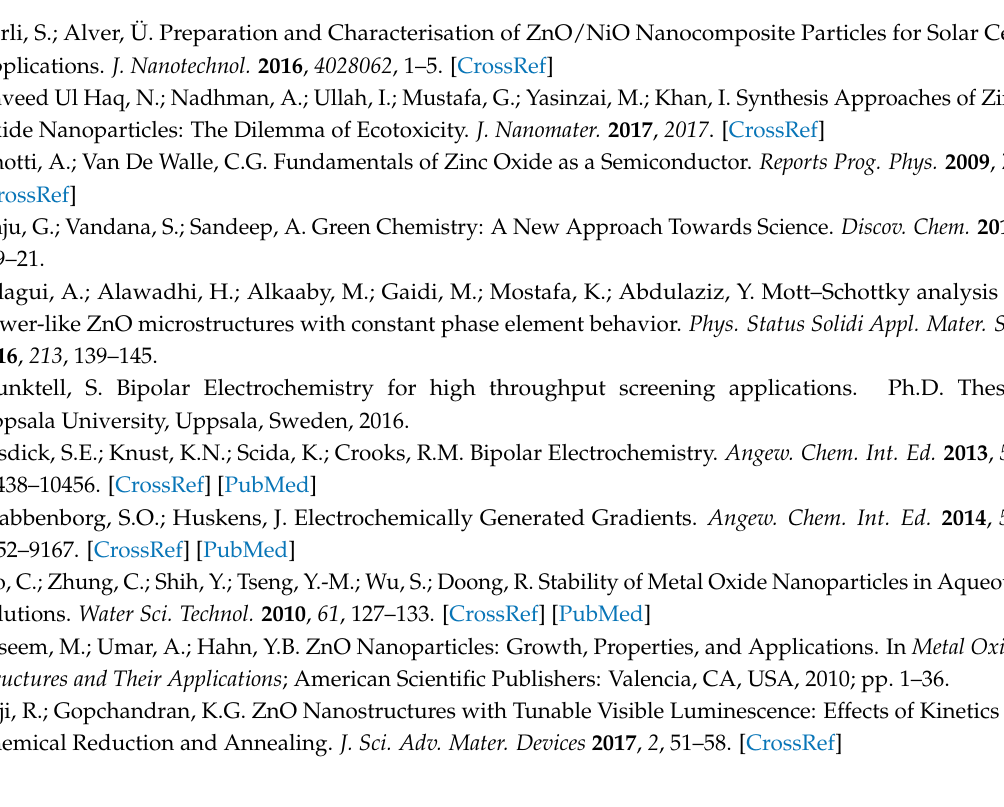
Figure S1: Reaction cell setup used for bipolar electrochemical synthesis. Figure S2: Images of the qualitative varying potential analysis performed at ( A ) 1.32 V, ( B ) 5 V, ( C ) 10 V, ( D ) 20 V, ( E ) 30 V, ( F ) 40 V, ( G ) 50 V, ( H ) 55 V, ( I ) 60 V and ( J ) 62.5 V. Figure S3: I–t graphs of current generation at varying applied potentials for both systems ( A ) without and ( B ) with a bipolar electrode (BPE) present. Figure S4: TEM image of a 2 h room temperature trial collected via evaporation showing the presence of larger agglomerates without any indication of smaller nanoparticles. Figure S5: TEM images of 2 h trials collected via filtration performed at ( A ) room temperature and ( B ) in an ice bath (~5 ◦ C). Figure S6: Overlay of the i–t graphs generated from trial data, which demonstrates the magnitude of current generated under various conditions. Figure S7: TEM images of 2 h room temperature trial with 10 mg hexamethylenetetramine (HMT) collected via evaporation resulting in both larger agglomerates and smaller nanoparticles ( A , B ) and 2 h room temperature trial with 10 mg PVP resulting solely in larger agglomerates ( C ). Figure S8: Comparison of pure white commercial ZnO ( left ) and 2 h synthesized sample ( right ) in ethanol depicting the off-white color obtained for the synthesized samples. Figure S9: SEM cross-sectional images of Fluorine doped tin oxide (FTO)-coated ZnO electrodes for (A) Com, (B) 3He, (C) 3Hf and (D) 2H samples. Figure S10: Bode diagram of the illuminated ZnO-based electrodes with the commercial and synthesized samples. Table S1: Comparison of charger-transfer resistance ( R ct ), transport resistance ( R tr ), an effective diffusion length ( L n ) and free-electron lifetimes ( t n ) under illumination estimated by impedance modelling and from Equation (13), 14in main